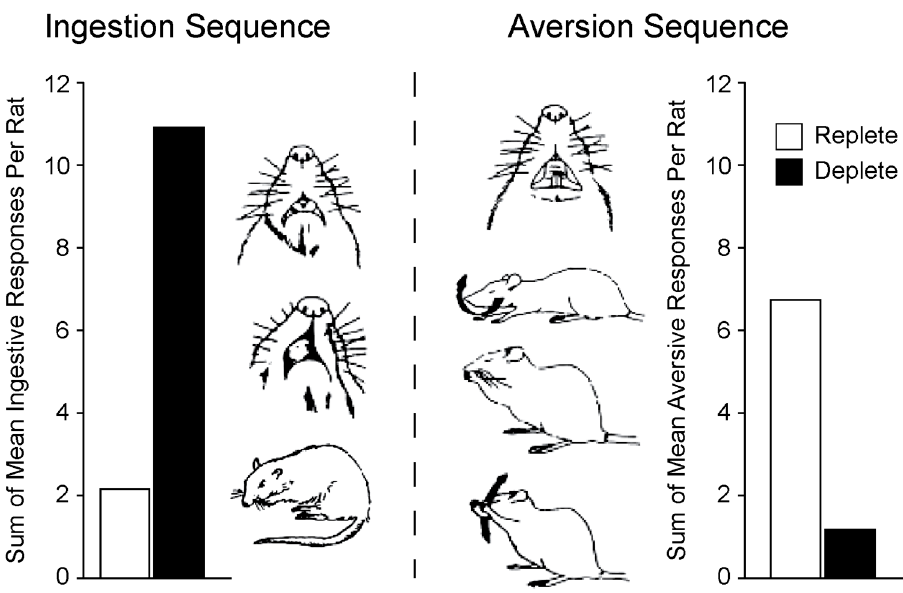
Figure 2. Sodium depletion changes taste responses to hypertonic saline. Data previously published in table form [16] were used to calculate mean ingestive and aversive responses after oral infusion of 3% NaCl. Sodium depletion caused a clear shift in the relative number of ingestion and aversion sequences of behavior. Drawings are from [45]. The figure was reproduced, with permission, from [46].